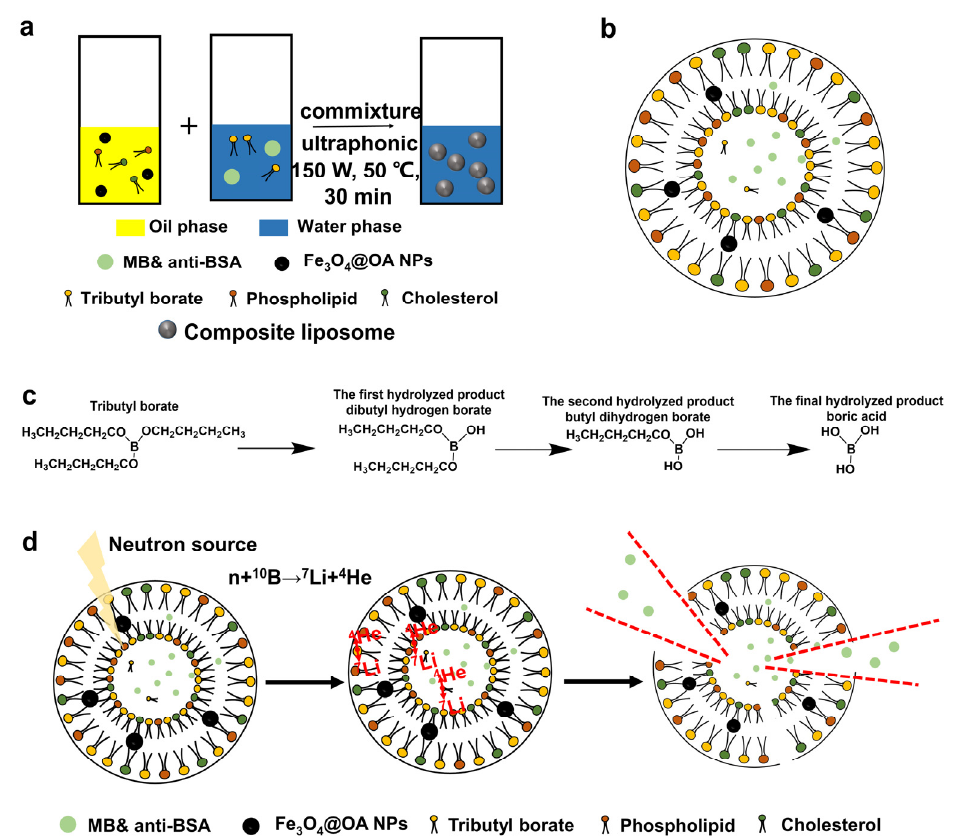
Figure 3. Process of the preparation of composite liposome by RPEM ( a ), diagrammatic cross-section of composite liposome ( b ), hydrolytic process of tributyl borate ( c ), and schematic diagram of the material released after neutron irradiation ( d ).